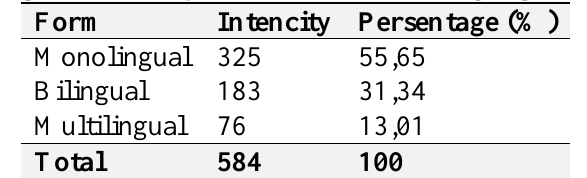
Table 4. Percentage of intensity of form based on language